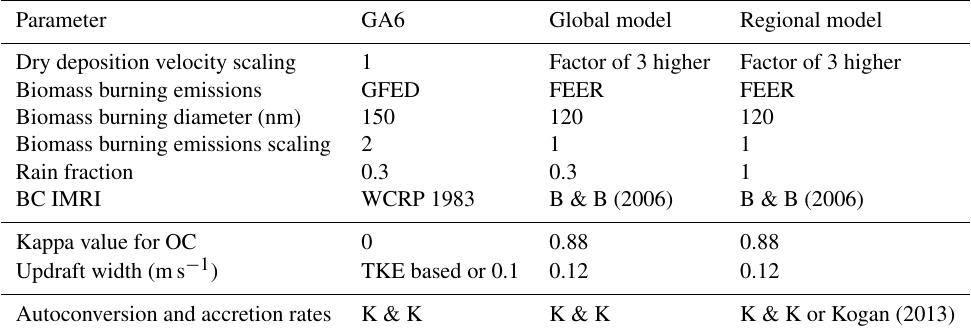
Table 1. Adjusted parameters in our simulations compared to the usual climate model. In the table, K & K refers to (Khairoutdinov and Kogan, 2000), and the change to the cloud scheme critical relative humidity and other parameters are defined in the text. GA6 is a standard configuration of the Unified Model described by (Walters et al., 2017b). IMRI refers to the imaginary part of the refractive index of black carbon (BC); organic carbon is abbreviated by OC, and B & B refers to (Bond and Bergstrom, 2006). Parameter GA6 Global